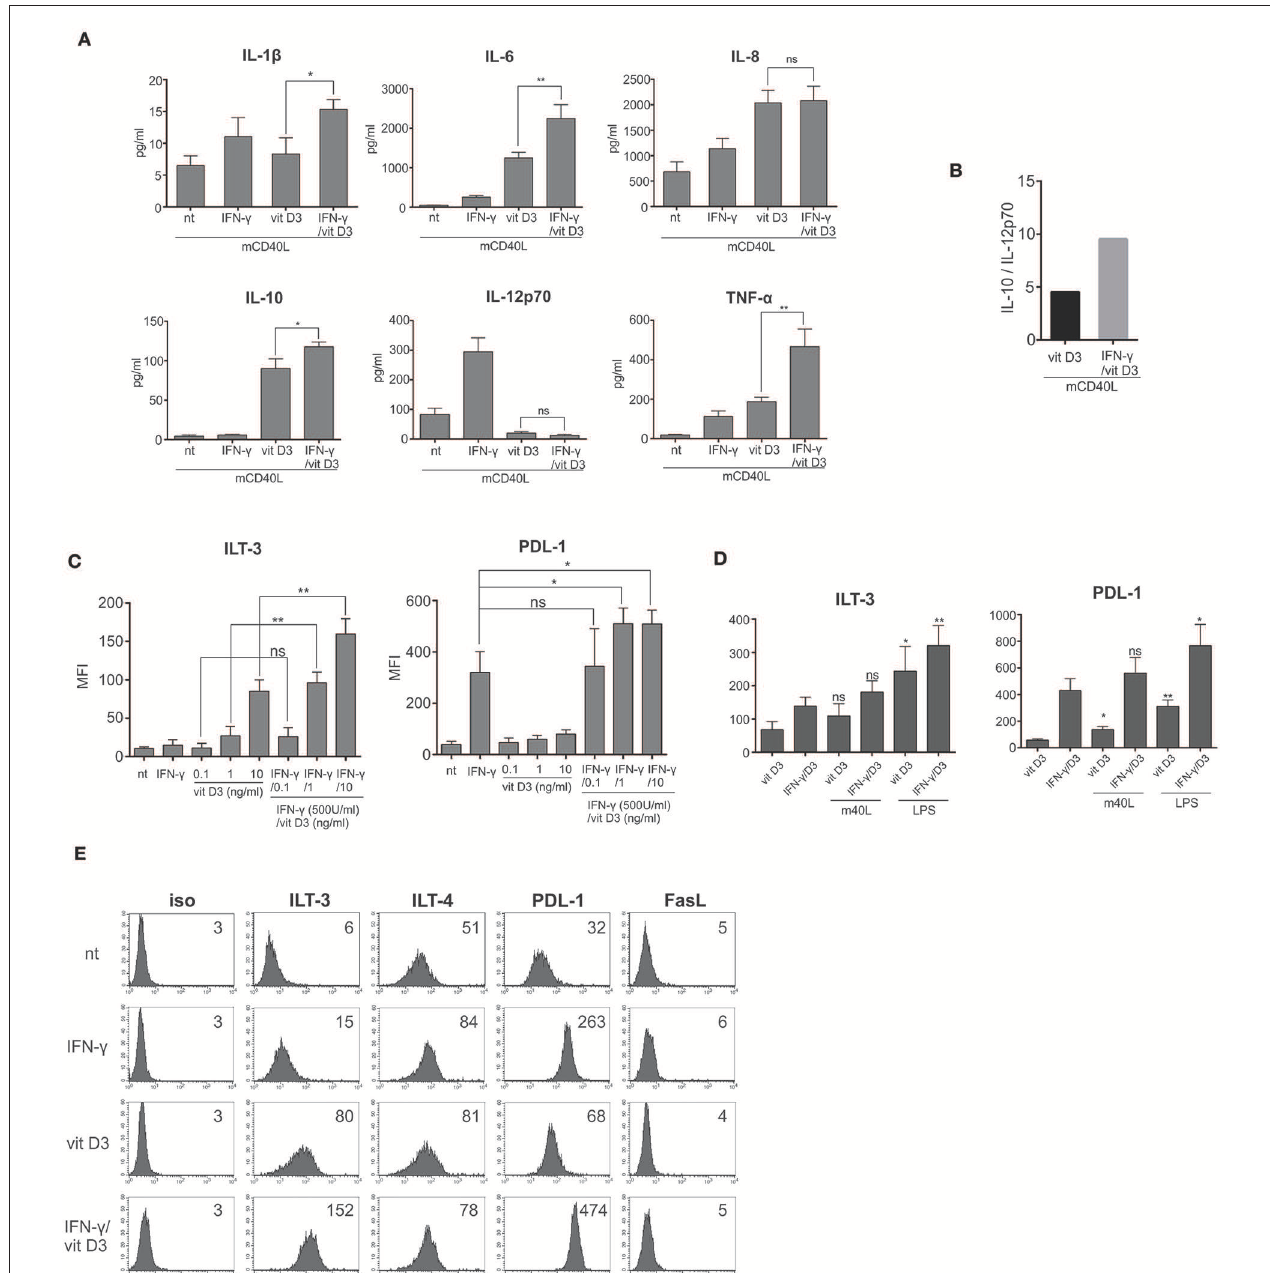
FIGURE 2 | γ /D 3 DCs exhibit an exceptional tolerogenic phenotype. (A) Immature DCs were left untreated or treated with IFN- γ (500 U/ml), vit D 3 (10ng/ml), or IFN- γ + vit D 3 at same concentrations. After 24h, the DCs were washed extensively and re-stimulated using multiple CD40 ligand for an additional 24h. Afterwards, the cell supernatants were analyzed for the presence of IL-1 β , IL-6, IL-8, IL-10, IL-12p70, and TNF- α . Shown are mean ± SD of four independent experiments. (B) The ratio between the capacity of D 3 DCs and γ /D 3 DCs to produce IL-10 vs. IL-12p70 was calculated by dividing mean values of both cytokines, determined in cell culture supernatants after 24h stimulation with CD40 ligand. (C) Immature DCs were treated with various concentrations of vit D 3 (0.1ng/ml, 1.0ng/ml, or 10.0ng/ml) in the presence or absence of 500 U/ml of IFN- γ . After 24h, surface expression of ILT-3 and PDL-1 was determined using flow cytometry. Shown are mean ± SD of MFI values calculated on the basis of five independent experiments. (D) Dendritic cells were treated with vit D 3 or IFN- γ + vit D 3 for 24h, followed by an addition 24h exposure to LPS (20ng/ml). Subsequently, expression of surface molecules ILT-3 and PDL-1 was analyzed and individual samples were compared to their counterpart, which was not stimulated with LPS. Shown are mean ± SD of MFIs of three independent experiments. (E) Dendritic cells were treated IFN- γ , vit D 3 , or combination of both and stained after 24h for surface expression of different inhibitory molecules. Shown is one representative out of five independent experiments performed. The numbers on histograms represent MFI values. Statistical significance between individual pairs was calculated using Student’s unpaired t -test (ns, non-significant; * p < 0.05; ** p <